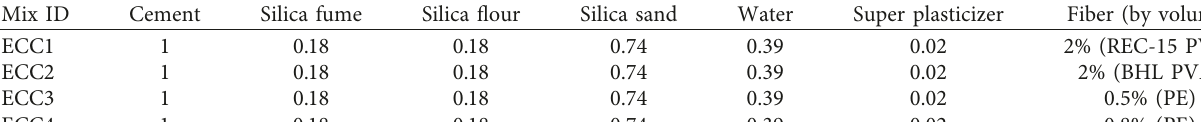
Table 3: Mix design of domestic ECCs (weight ratios).